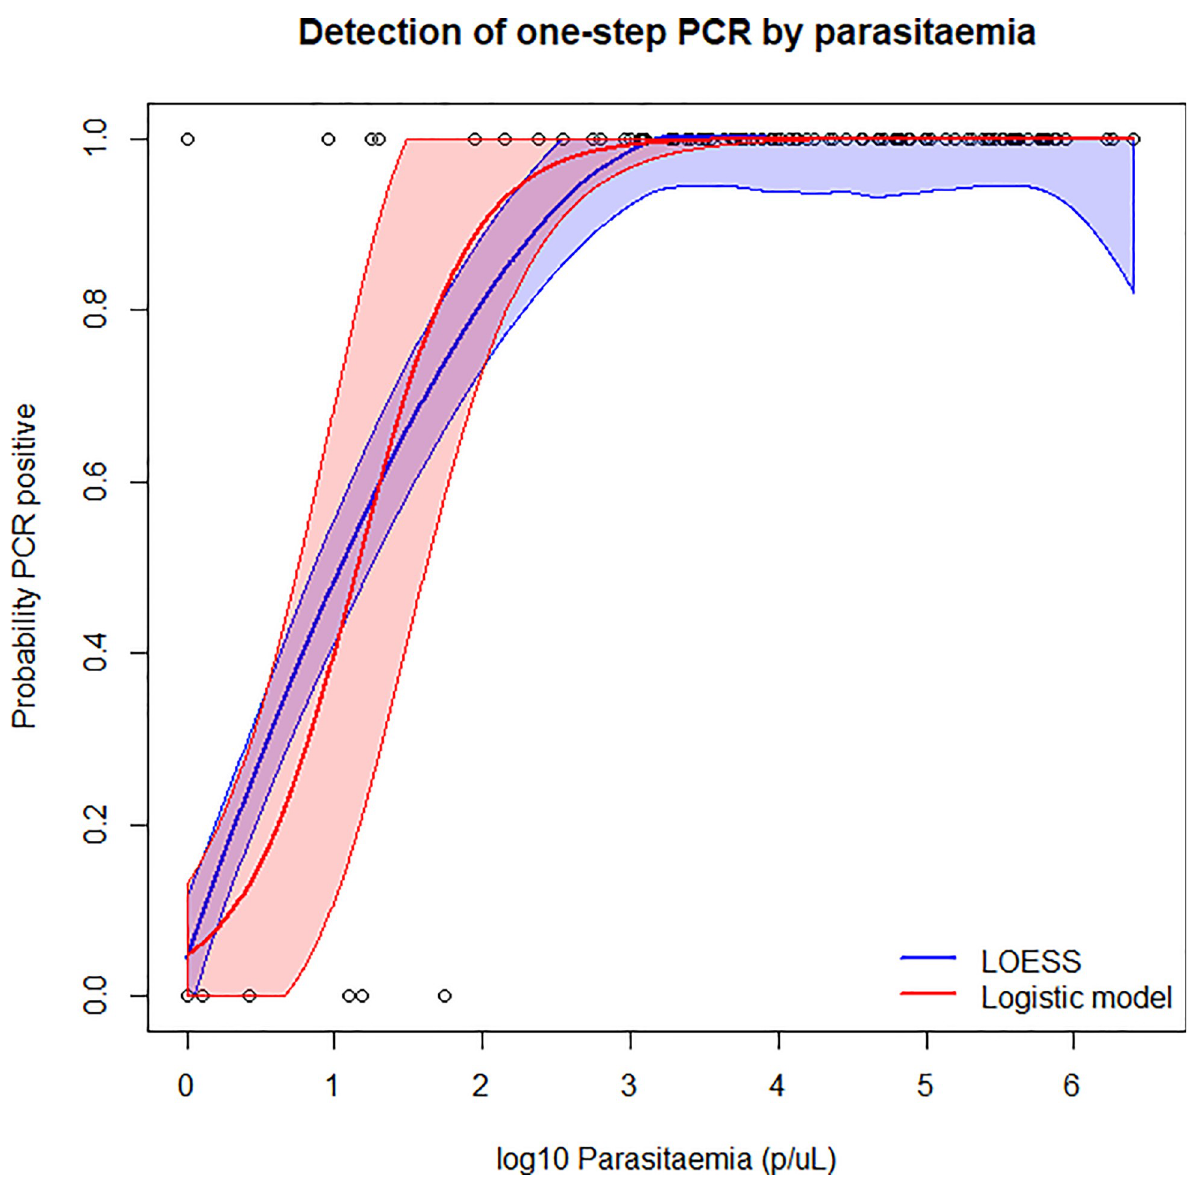
Fig 2. Probability of being one-step PCR positive, by log parasitaemia. 95% confidence intervals of the LOESS and logistic models are indicated by the color bands.